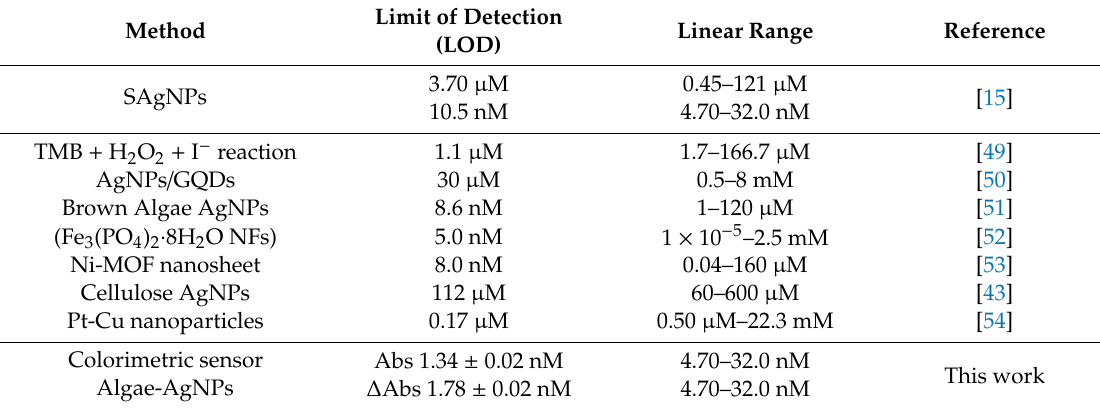
Table 1. Comparison of analytical performances of di ff erent H 2 O 2 colorimetric